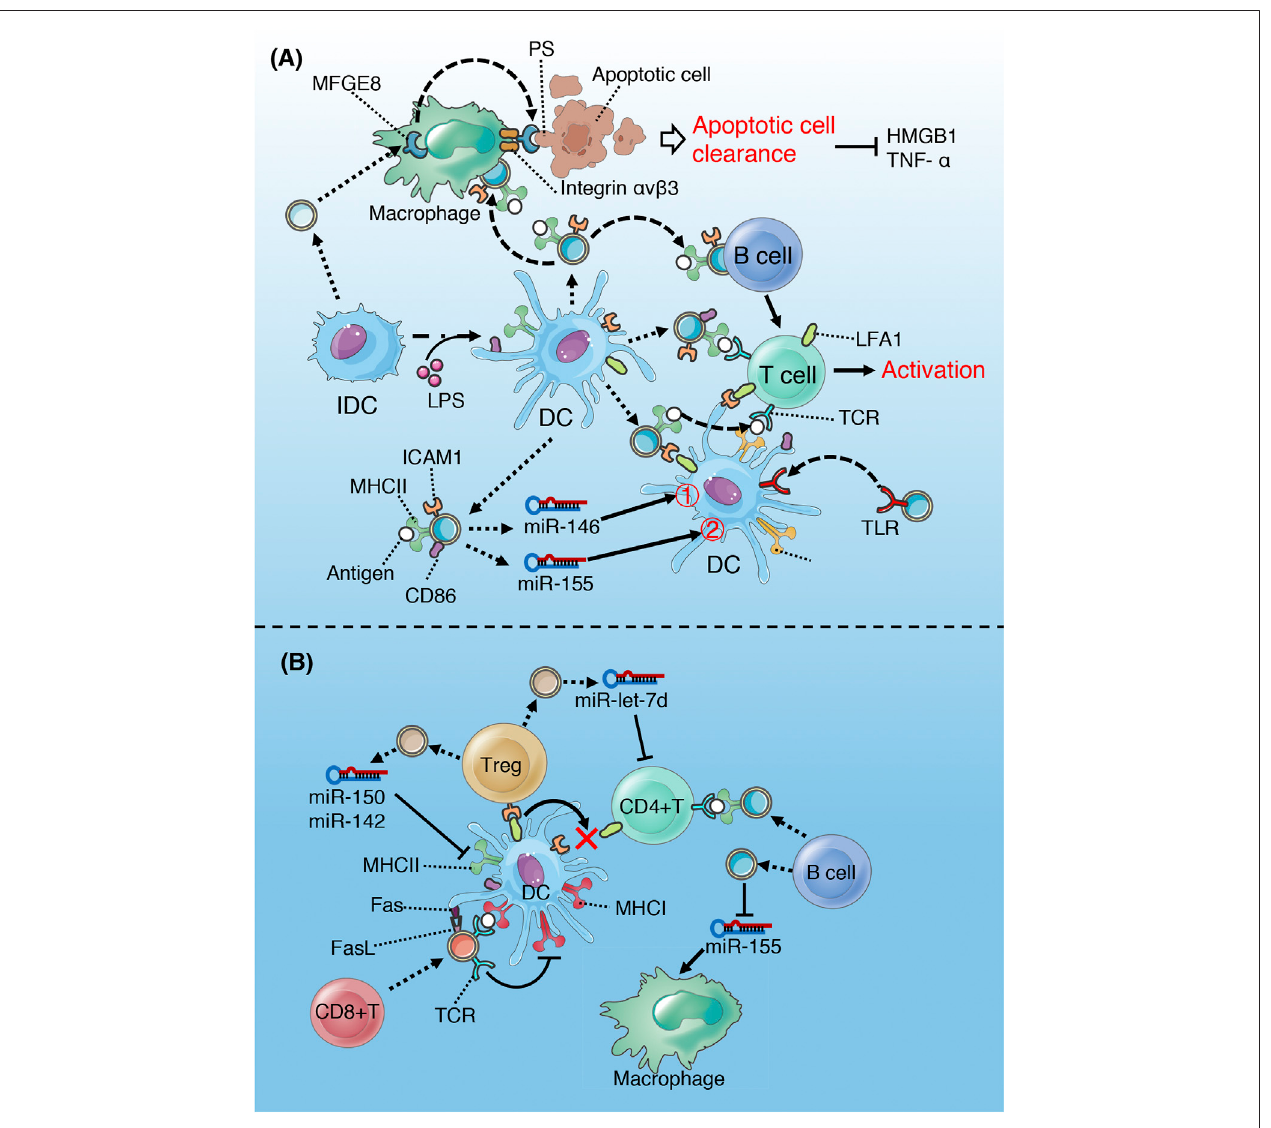
FIGURE 8 | Role of exosomes derived from DC and lymphocyte in sepsis. (A) IDC-derived exosomes promote MFGE8-mediated phagocytosis of apoptotic cells by macrophage. DC-derived exosomes can activate antigen-speci fi c T cells according to antigen presentation described above. In addition, miR-146 in DC-derived exosomes alleviate in fl ammatory response of recipient DC via inhibiting IRAK1/TRAF6/NF- κ B ① , while exosomal miR-155 aggravate in fl ammatory response by suppressingBACH1andSHIP1 ② signalingpathways. (B) exosomesderivedfromTreginduceanimmunetolerancephenotypeofDCandinhibitTcellproliferation. Exosomesreleased byCD8+TcellinhibittheabilityofDCtoactivateTcellsandinduceDCapoptosis.However,exosomesderivedBcellcanactivateTcell,andalsobe used as drug carrier of immunotherapy.